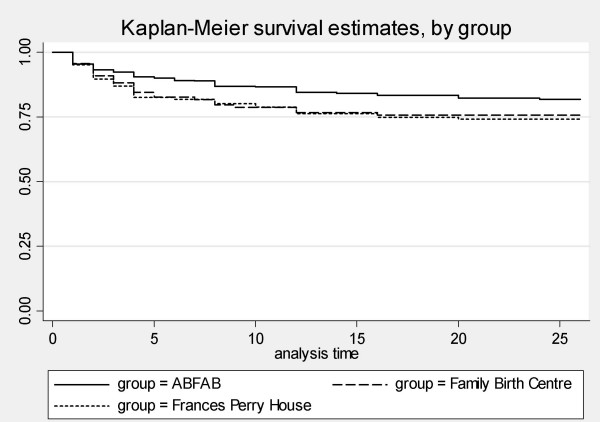
Timing of mastitis, by group.